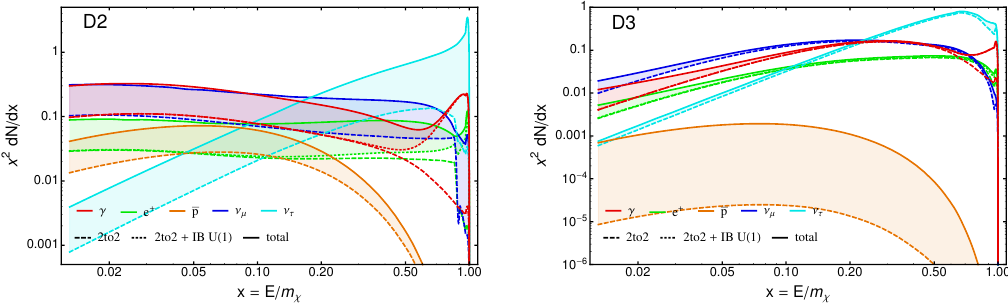
Figure 12 . Same as (cid:12)gure 11, but now for models where both squarks and sleptons are degenerate in mass with the neutralino (model D2, left panel) or with a degenerate stau that is a mixture of ~ (cid:28) L and ~ (cid:28) R (model D3, right